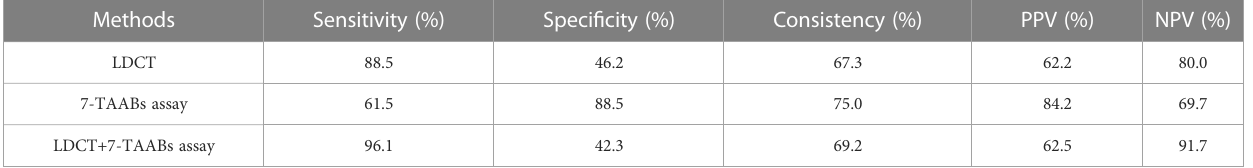
TABLE 5 Comparison of LDCT, 7-TAABs assay, and the combined model for the detection of lung cancer. Methods